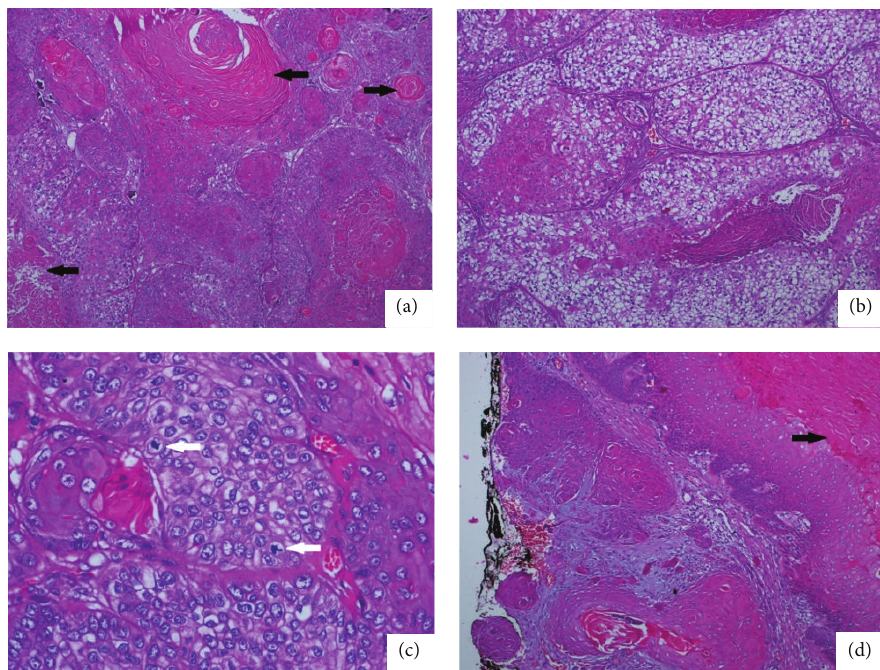
Figure1:Acaseofmalignantproliferatingtrichilemmaltumor(H&E, × 100).Tumorcellsdesignedinsolidgroupsareobserved.Trichilemmal keratinization (black arrow) at the center of the tumor islands is remarkable (a). The tumor cells with wide translucent cytoplasm are observed more remarkably (b). Atypical mitotic figures in the tumor are remarkable (white arrow) (c). A focal invasion field in the peripheral tumor is observed. The tumor is continuous along the surgical margin labeled by black tissue stain. The focus is on trichilemmal keratinization in the tumor (black arrow)